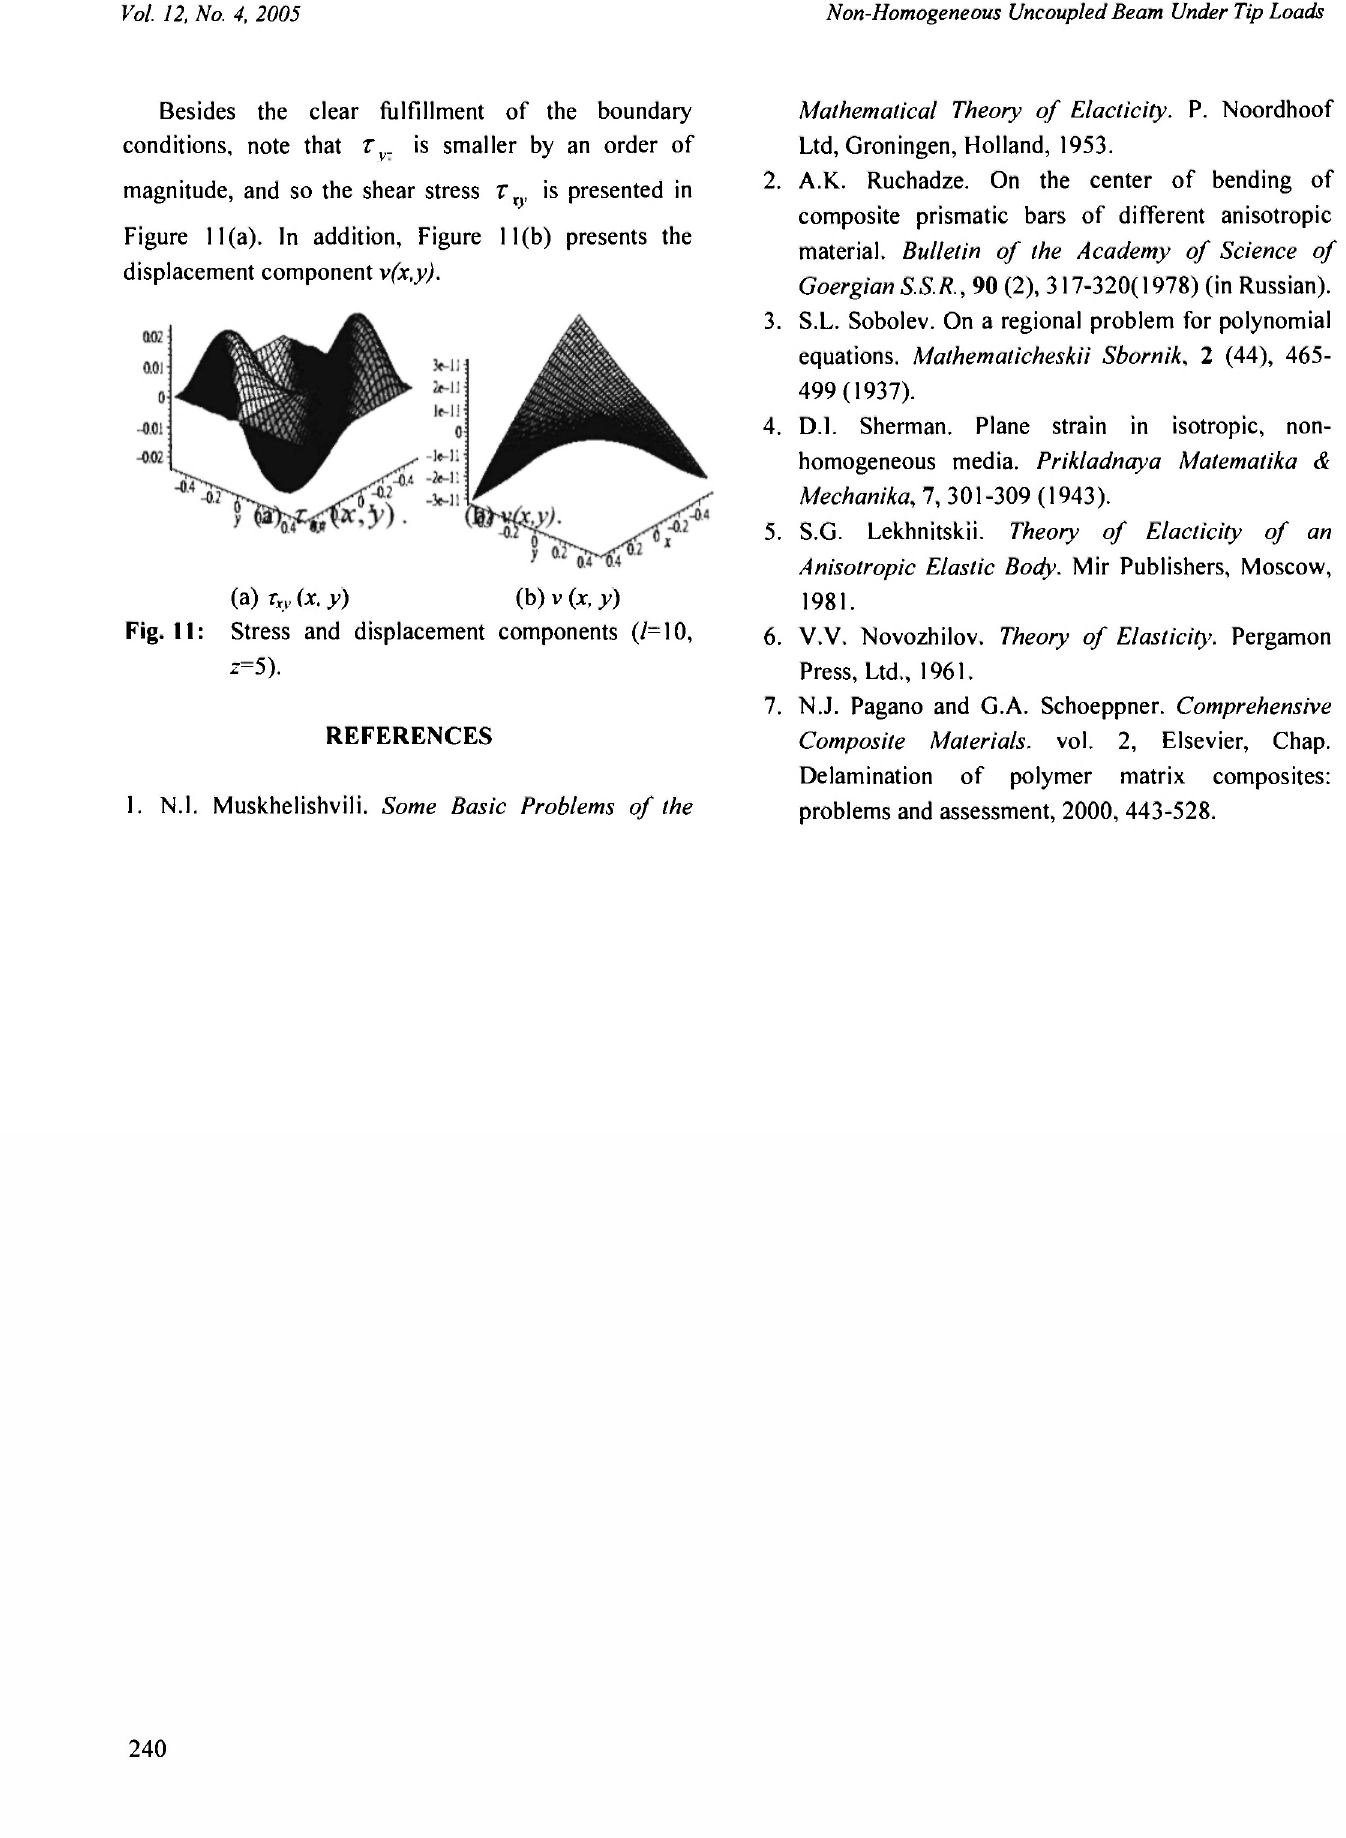
Fig. 11: Stress and displacement components (/=10,